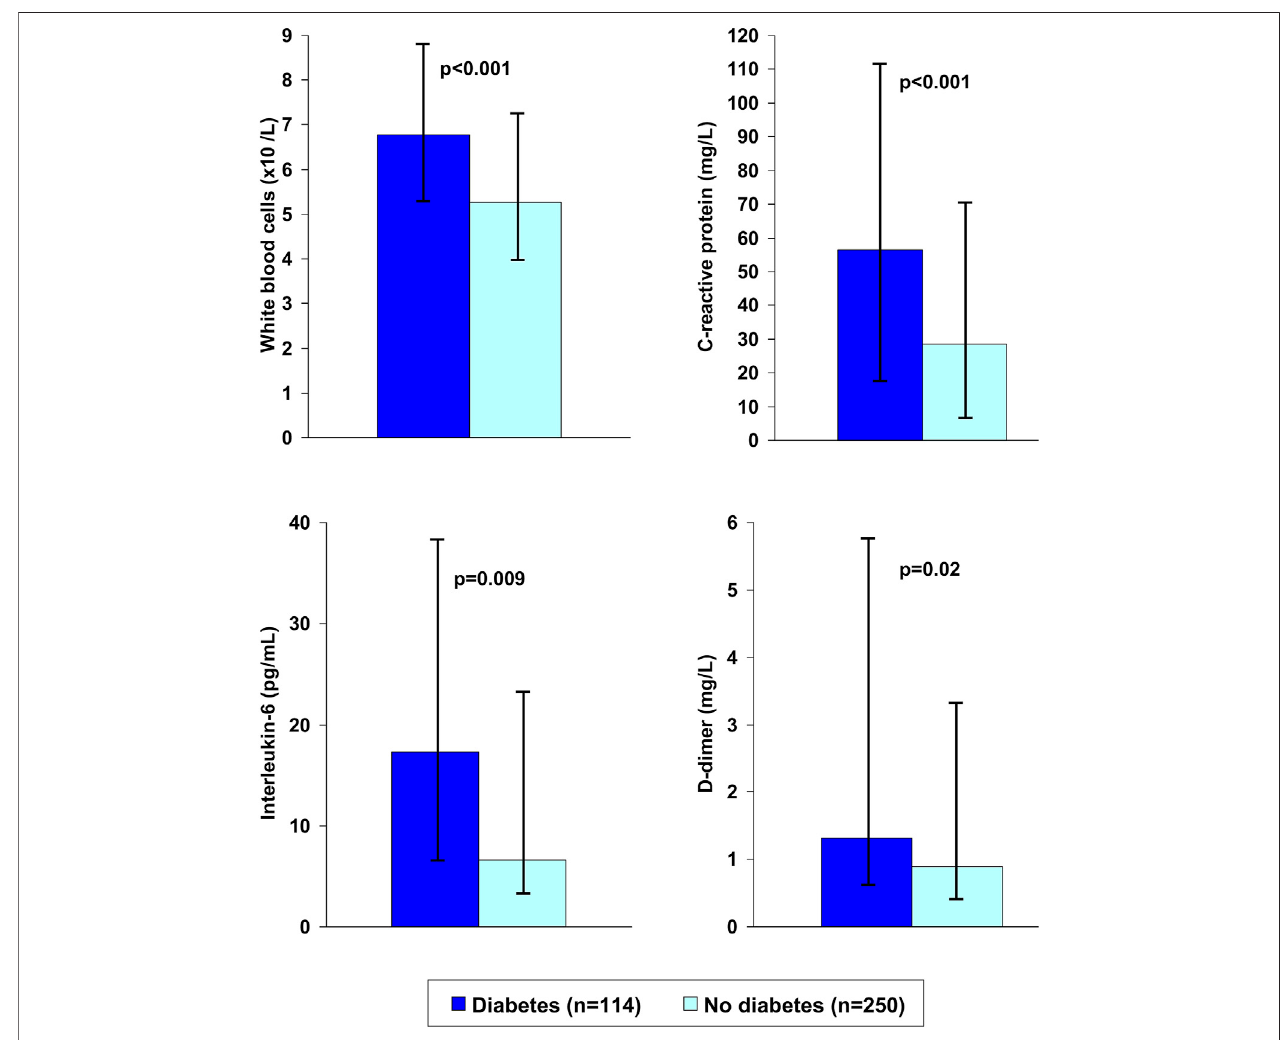
FIGURE 2 | Markers of systemic in fl ammation and blood coagulability in patients with or without type 2 diabetes who died from Covid-19. Data are medians and interquartile ranges. Drawn from data presented by Xu et al., 2020.